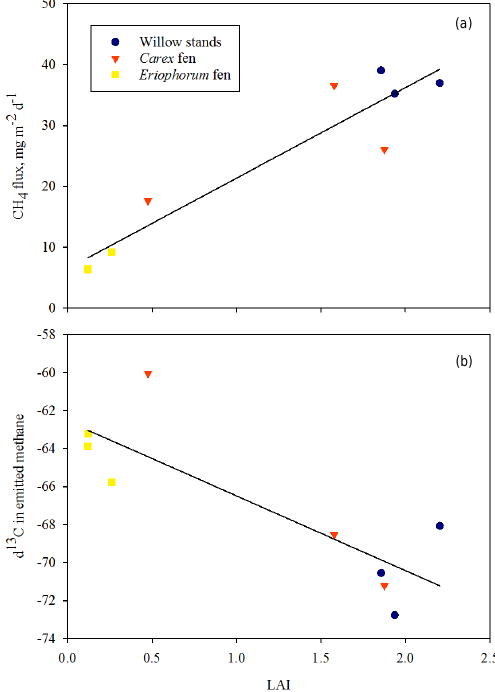
Figure 4. Correlation between cumulative seasonal CH 4 fluxes with (a) mean vascular LAI, (b) δ 13 C of CH 4 flux recorded in different wetland LCTs during the 2008 growing